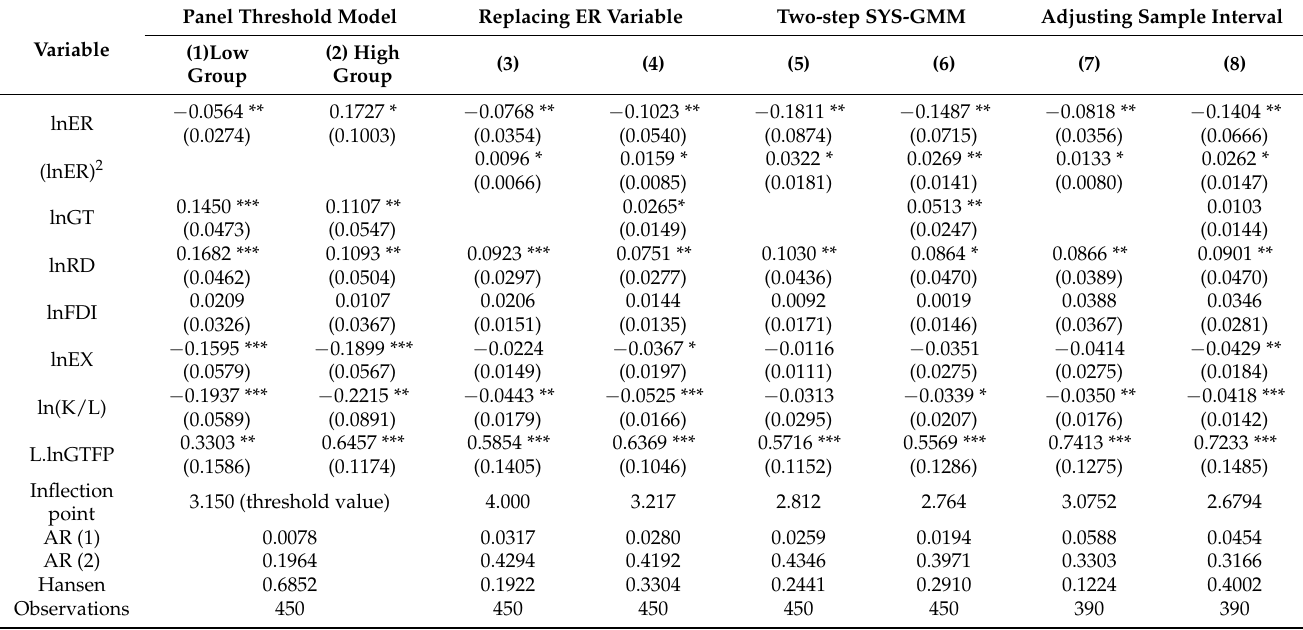
Table 5. Robustness test results of impact of environmental regulation on